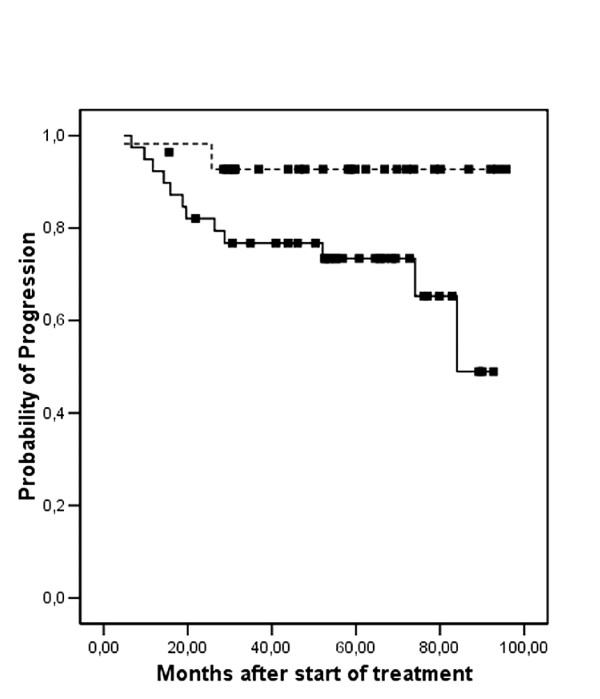
Relapse-free survival of patients with stages Ia/Ib OR tumor grade 1 (--)  vs. stages Ic/IIa/IIb AND tumor grade 2/3 (-).